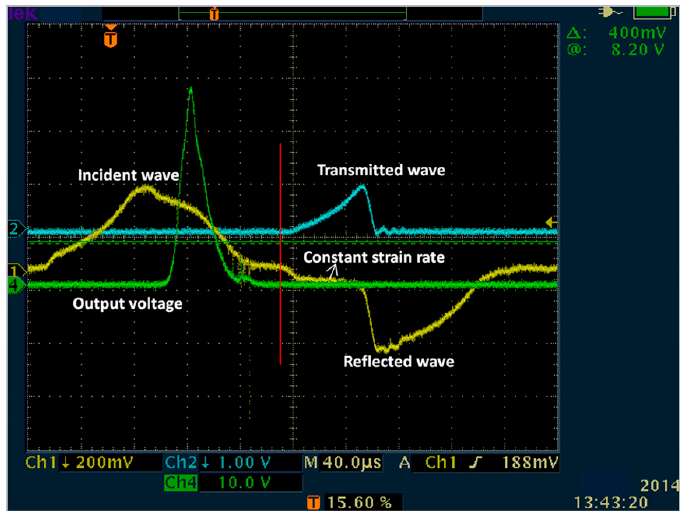
Figure 3. Date recorded in an SHPB test.